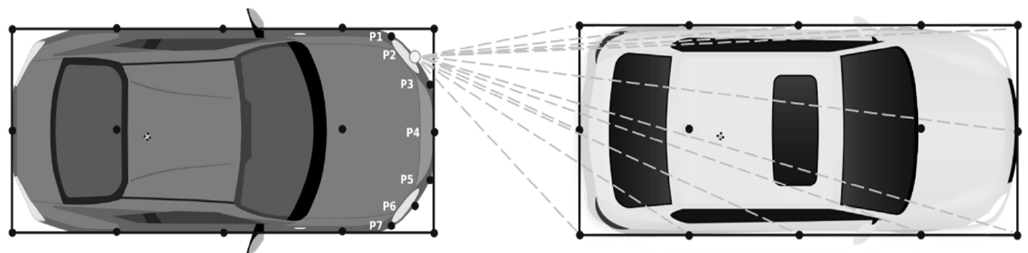
Figure 13. Representation of minimum V2V distance.